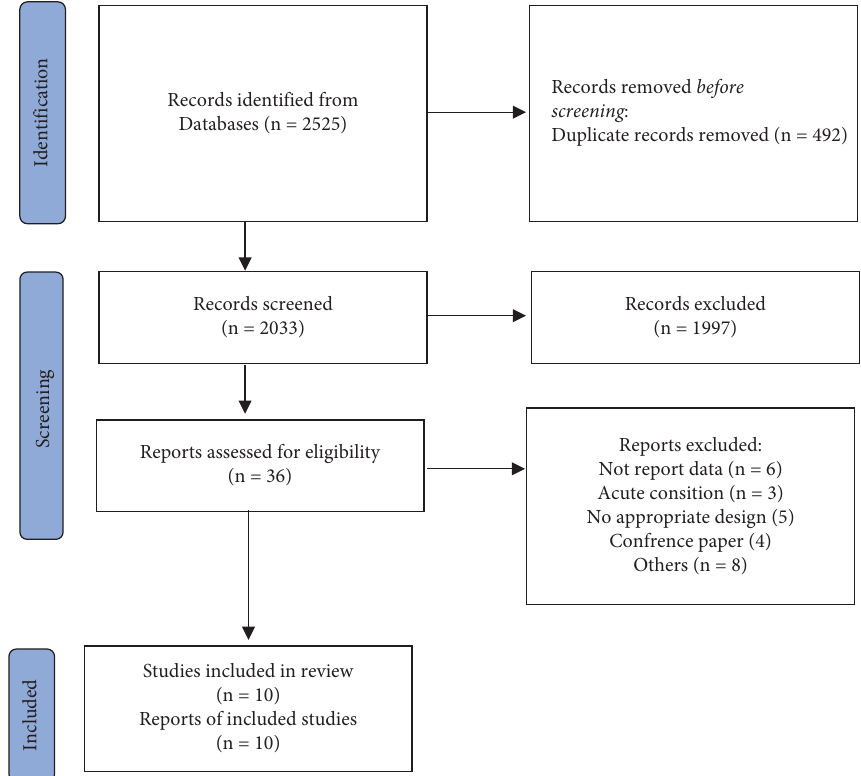
Figure 1: Summary of the search strategy and selection process based on included and excluded